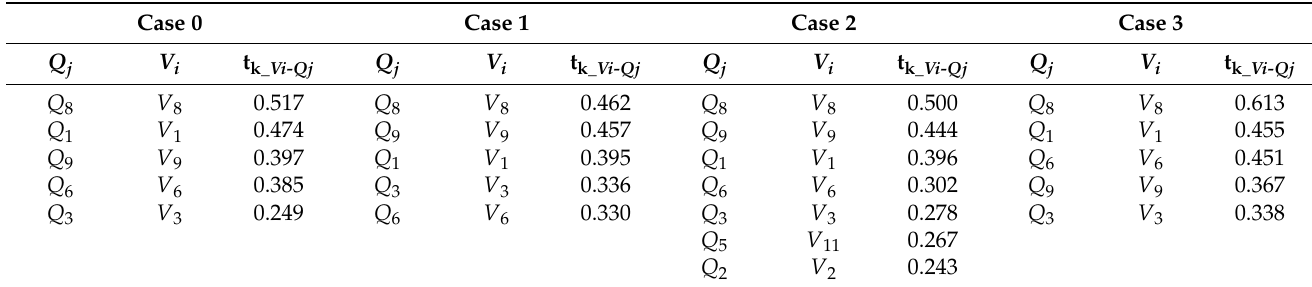
Table 23. Nodal Reactive Powers and Nodal-Voltage Magnitudes between which There Are the Strongest CRs (from the Point of View of the Considered Power) and KRCCs Characterizing These CRs for Case 0, Case 1, Case 2, and Case 3.